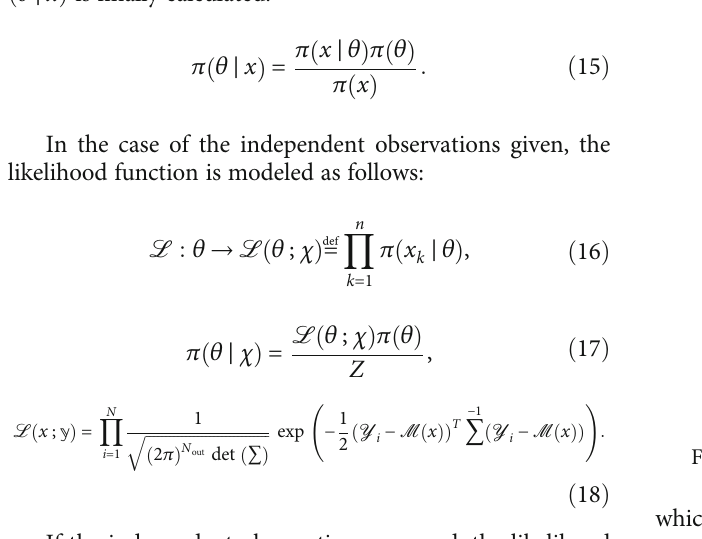
Figure 6: Pressure distributions along the base radius.